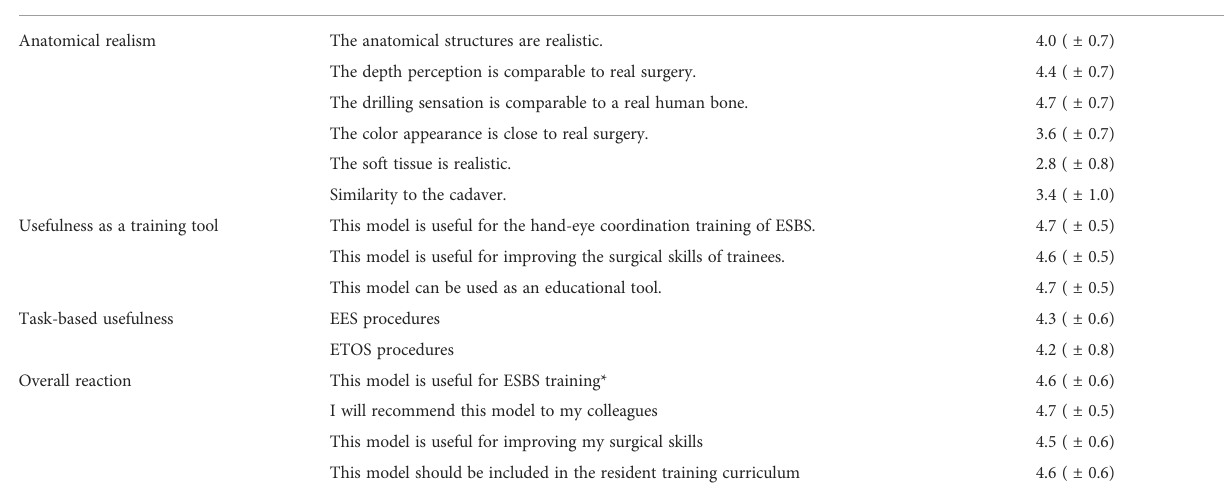
TABLE 2 Validation of the simulation model.